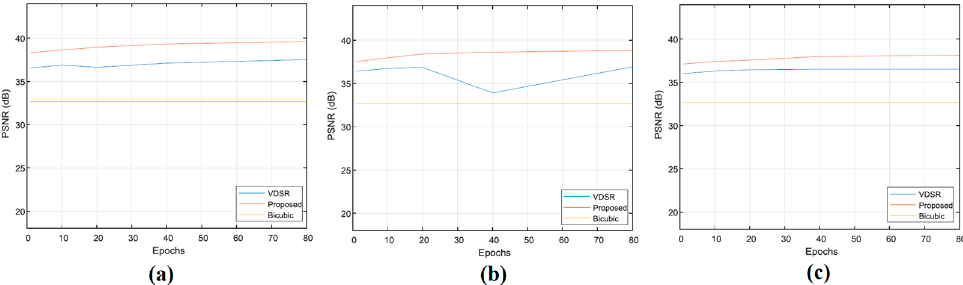
Figure 5. Performance comparison with VDSR and bicubic algorithms based on learning rates: ( a ) 0.1, ( b ) 0.01, and ( c ) 0.001.